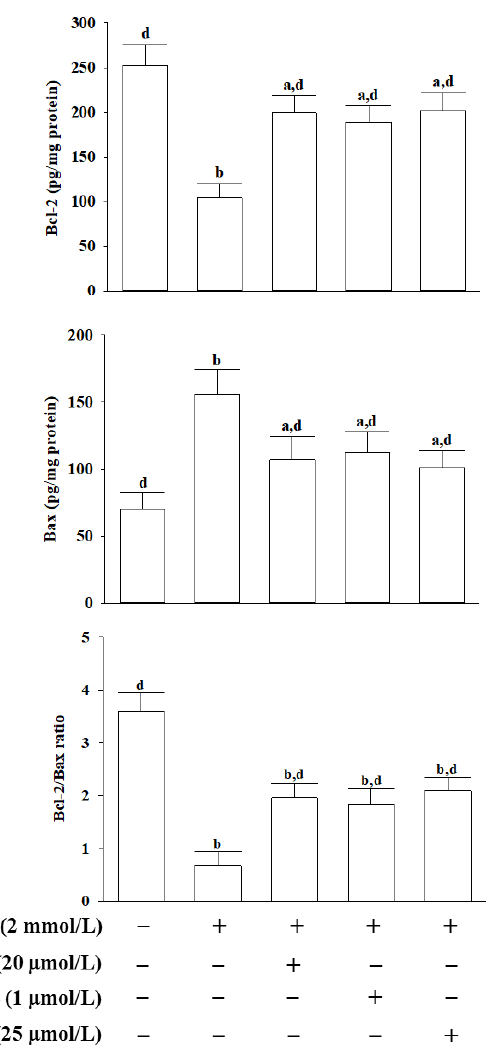
Figure 4. Hispidin reduces JNK-associated Bcl-2 pathway mediated by MPP + . MS23.5 cells were pretreated with hispidin (20 µmol/L), JNK-IN-8 (1 µmol/L), or SR3576 (25 µmol/L) for 1 h and then exposed to 2 mmol/L MPP + for another 24 h. ( A ) Phosphorylation of JNK and c-Jun has been detected in ELISA kits available on the market. ( B ) Levels of Bcl-2 and Bax were measured through ELISA with commercially available kits. The ratio of relative intensities in Bcl-2 to Bax (Bcl-2/Bax) was reported. The results are shown as the mean ± SD of five independent experiments ( n = 5) performed in triplicate. a p < 0.05 and b p < 0.01 compared to the untreated control group. c p < 0.05 and d p < 0.01 compared to the untreated MPP + group.